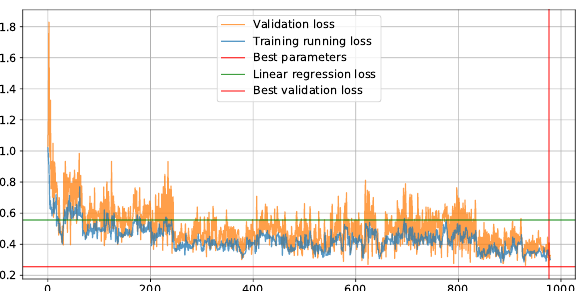
Figure 5. Evolution of training and validation losses during CalibNet network training on dataset Aude1. Green line indicates loss achieved by linear regression. Red lines indicate best loss and iterations.